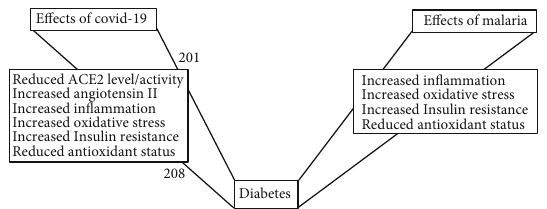
Figure 2: E ff ects of COVID-19 and malaria on the development of